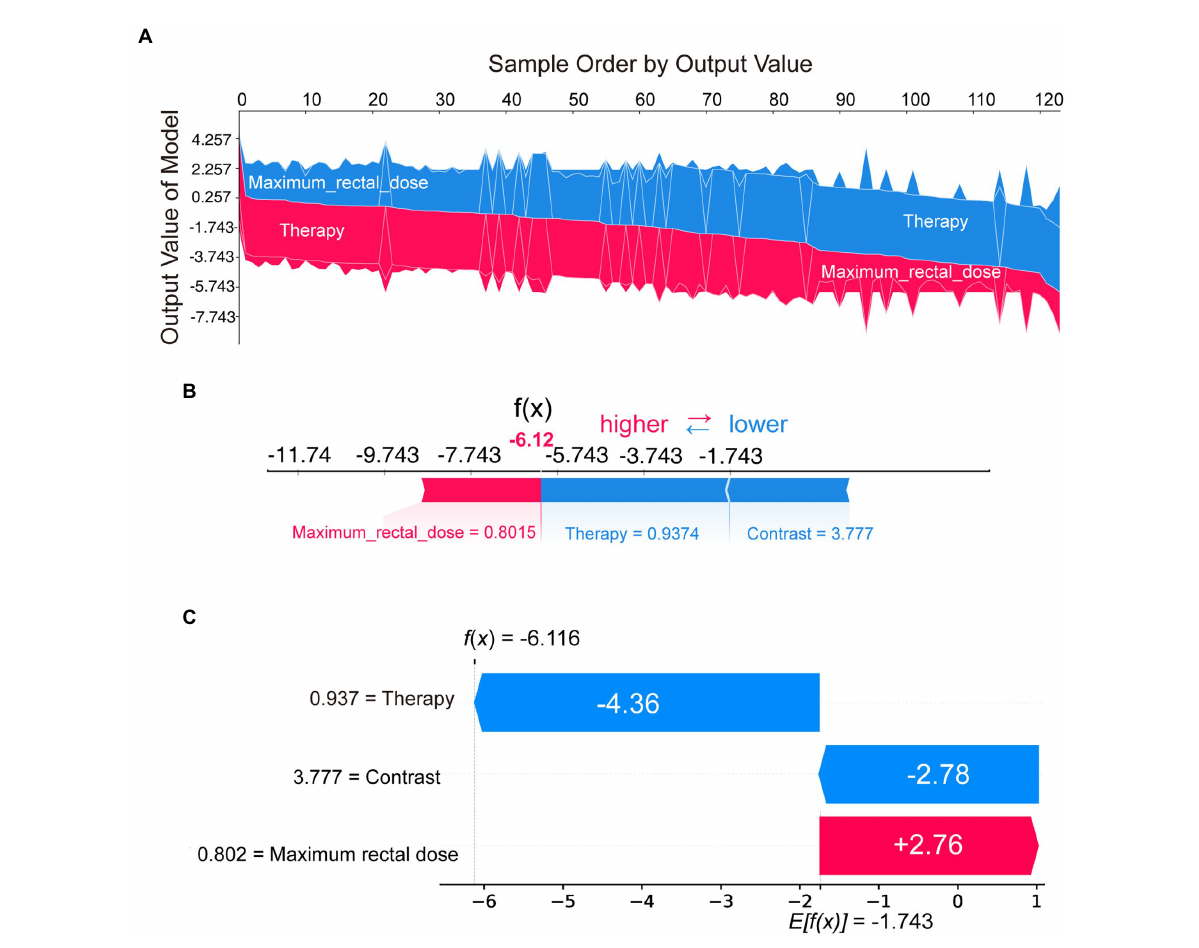
FIGURE 4 SHAP plots demonstrated SHAP values from a case-based perspective. Sampled by model output, the overall SHAP plot (A) showed the decision process of all patients. The force plot (B) and the waterfall plot (C) demonstrated the proportion and absolute SHAP value of various features in the decision-making process for a single